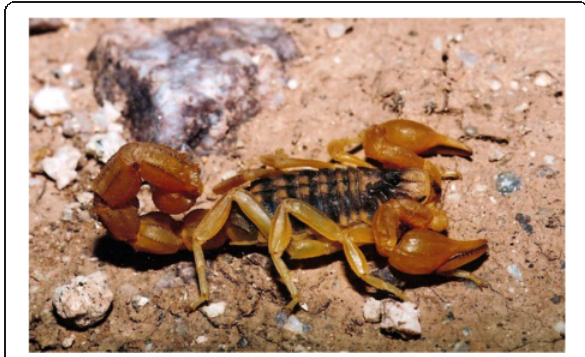
Fig. 3 Buthus albengai Lourenço, 2003; male from Morocco (copyright by Philippe Geniez, reproduced with permission)